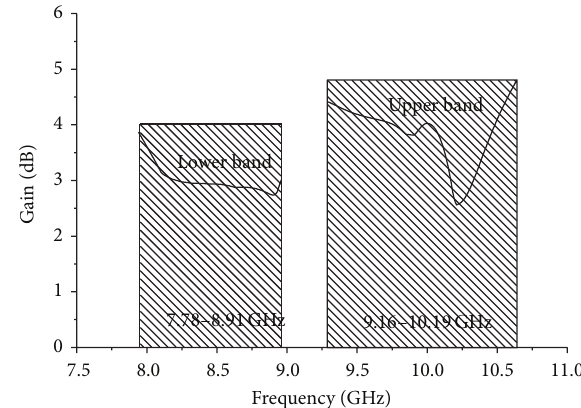
Figure 18: Achieved gains of the proposed antenna prototype.